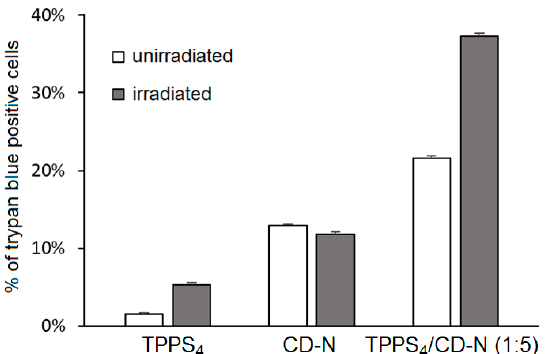
Figure 43. Cell death percentage in HeLa using trypan blue assay. HeLa cells were treated with free TPPS 4 (1.7 µM) and unloaded CD-N as controls, and with TPPS 4 /CD-N nanoassemblies prepared at 1:5 molar ratios, respectively. TPPS 4 amount was fixed at 1.7 µM. Samples were exposed to visible light irradiation ( λ = 340 nm, 5 J/cm 2 , 30 min). Adapted from Mazzaglia; Micali; Villari; Zagami; Pennisi; Mellet; Fernandez; Sciortino; Scolaro